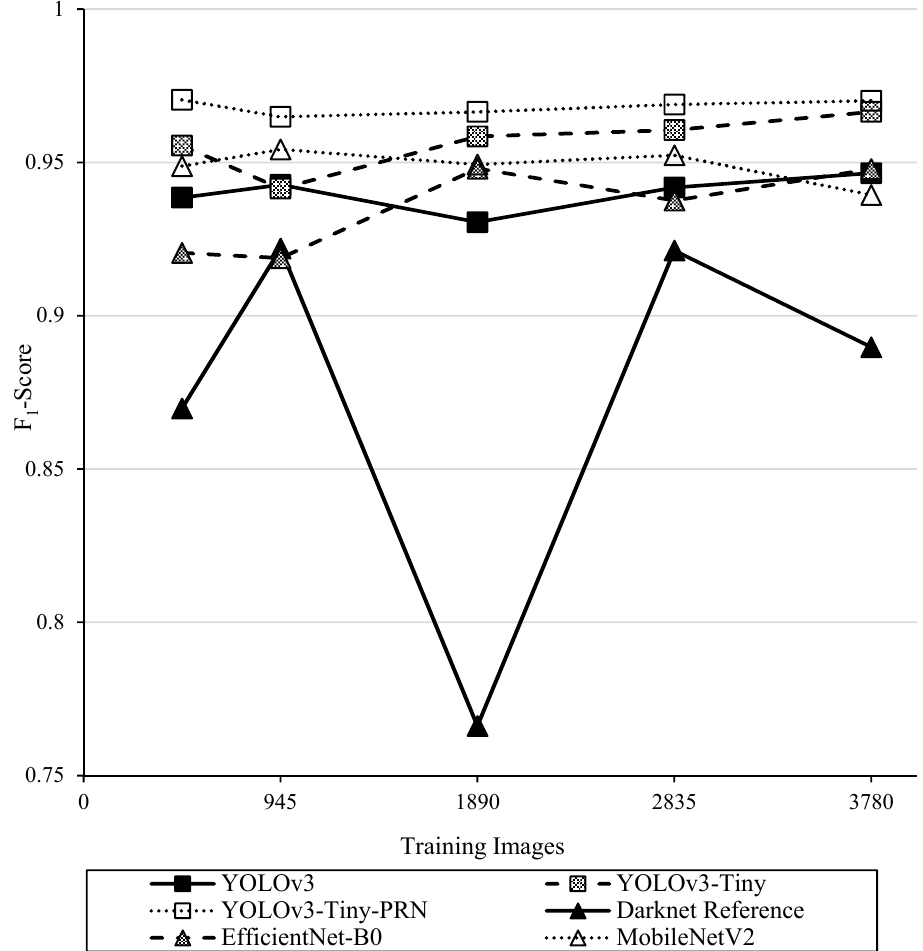
Figure 7. F 1 -scores for object-detection CNNs at 1280 × 736 resolution when trained with different dataset sizes.